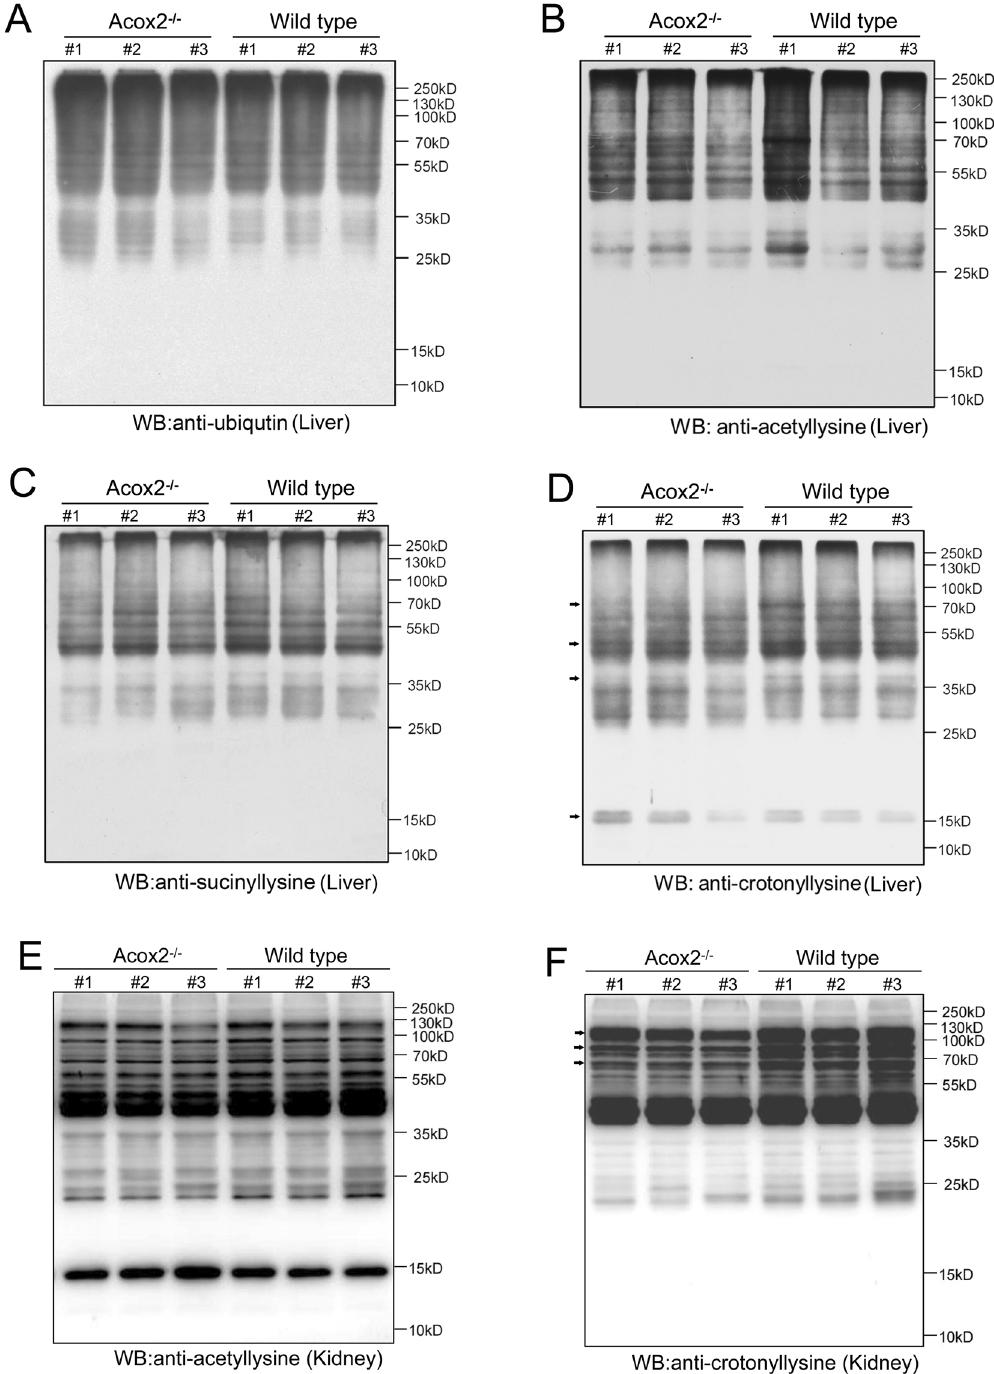
Fig. 4 Downregulation of non-histone Kcr in Acox2 − / − mice. A – D Overview of anti-ubiquitin ( A ), -succinyl lysine ( B ), -acetyl lysine ( C ), and – crotonyl lysine ( D ) in liver tissues of Acox2 − / − ( n = 3) and WT ( n = 3) mice using corresponding pan-antibodies by western blots. E , F Overview of anti-acetyl lysine ( E ), and – crotonyl lysine ( F ) in kidney tissues of Acox2 − / − ( n = 3) and WT ( n = 3) mice using corresponding pan- antibodies by western blots. speci fi c mutagenesis to mimic a decrotonylated status. Croto- nylation of Ehhadh (Fig. 6F, G) and Crot (Fig. 6H, I) was further con fi rmed by using immunoprecipitation assays in HEK-293T and HepG2 cell lines overexpressing Myc-tagged Ehhahdh or Crot recombinant proteins, respectively. Mutating lysine to arginine in Kcr sites of Crot (K 69 R and K 384 R) or Ehhadh (K 329 R, K 344 R and K 572 R) reduces Kcr levels to various degrees in vitro